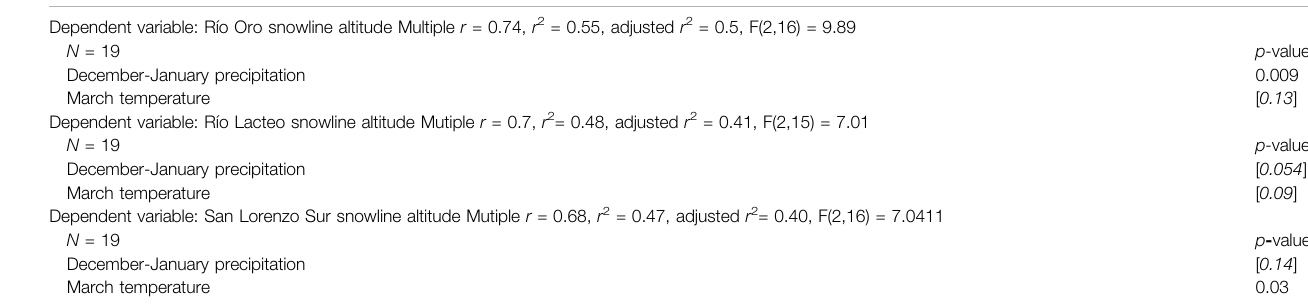
TABLE 5 | Regression summaries for snowline altitudes at individual glaciers using March temperature and December-January precipitation as predictors. Non-signi fi cant r values at p < 0.05 are marked in [ Italics ]. Dependent variable: Río Oro snowline altitude Multiple r (cid:2) 0.74, r 2 (cid:2) 0.55, adjusted r 2 (cid:2) 0.5, F(2,16) (cid:2) 9.89 N (cid:2)